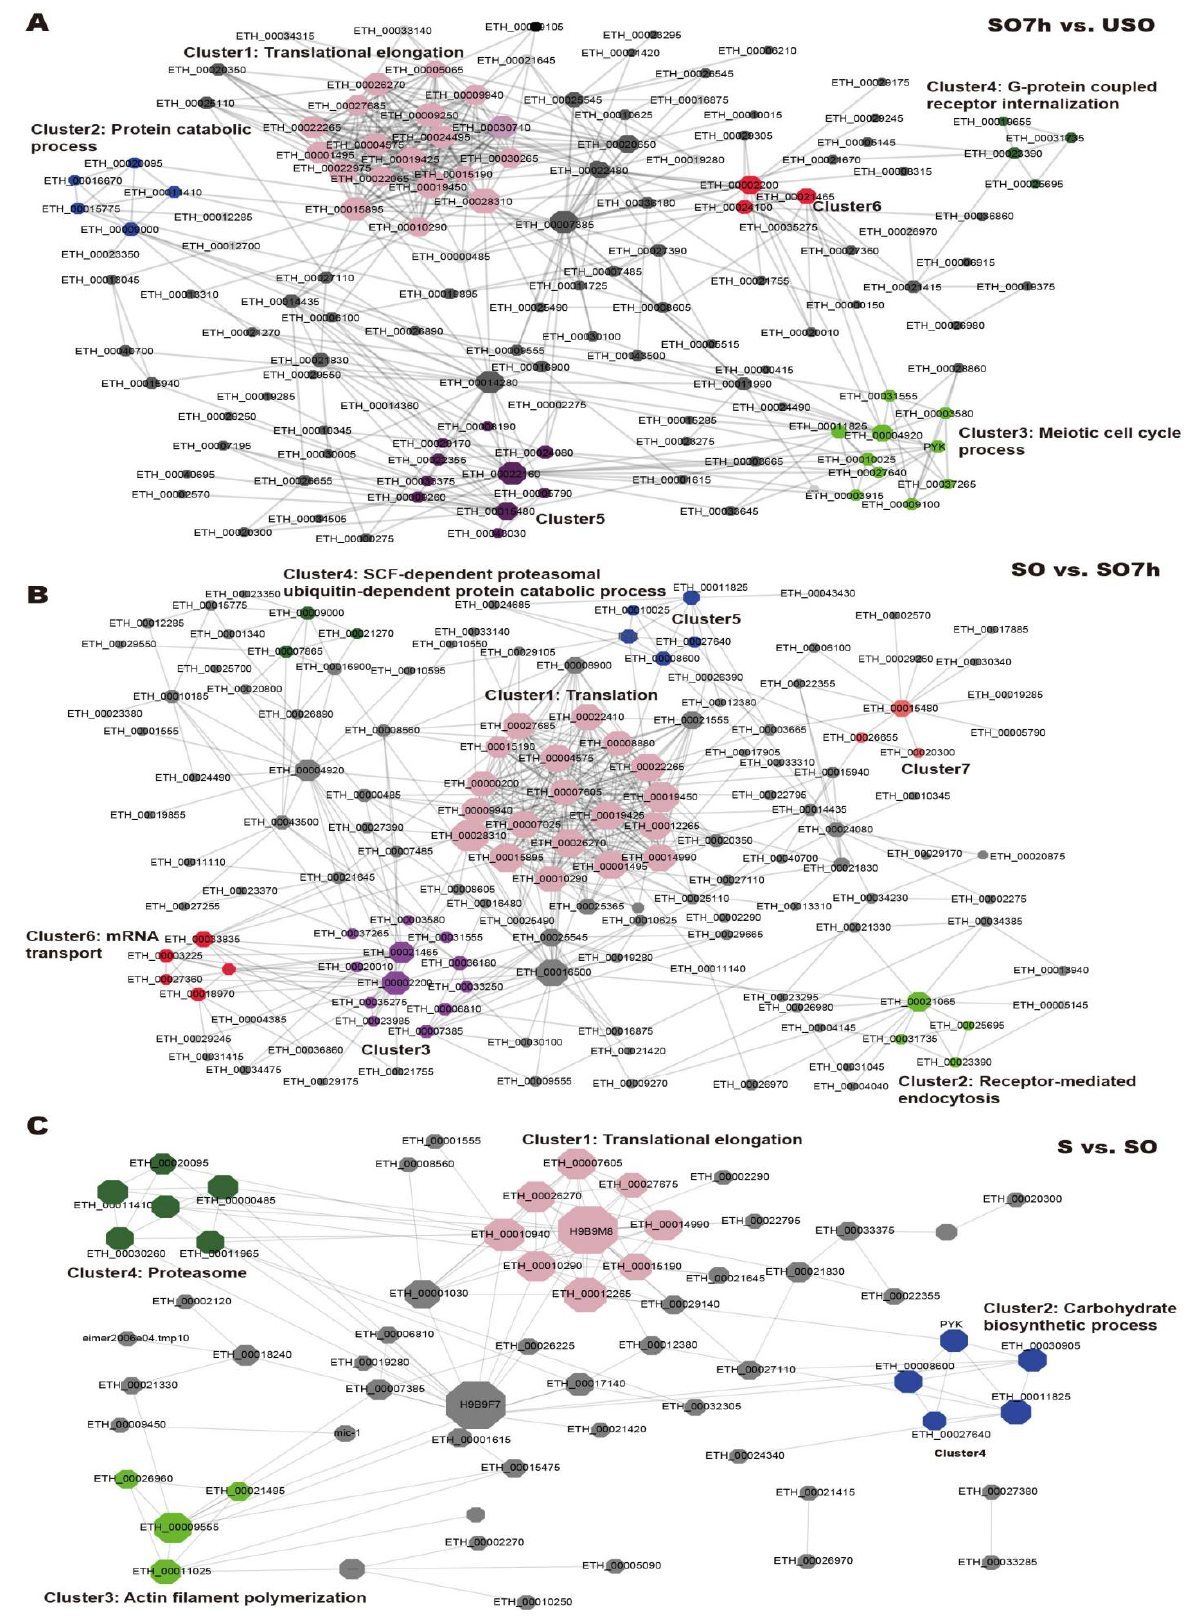
Figure 5. PPI networks for DEPPs based on each comparison. ( A ) SO7h vs. USO. ( B ) SO vs. SO7h. ( C ) S vs. SO. The node size represents the node degree in the PPI network; the nodes in the same module are arranged with the same color and nodes in grey represent proteins which are not clustered in any module using MCODE.